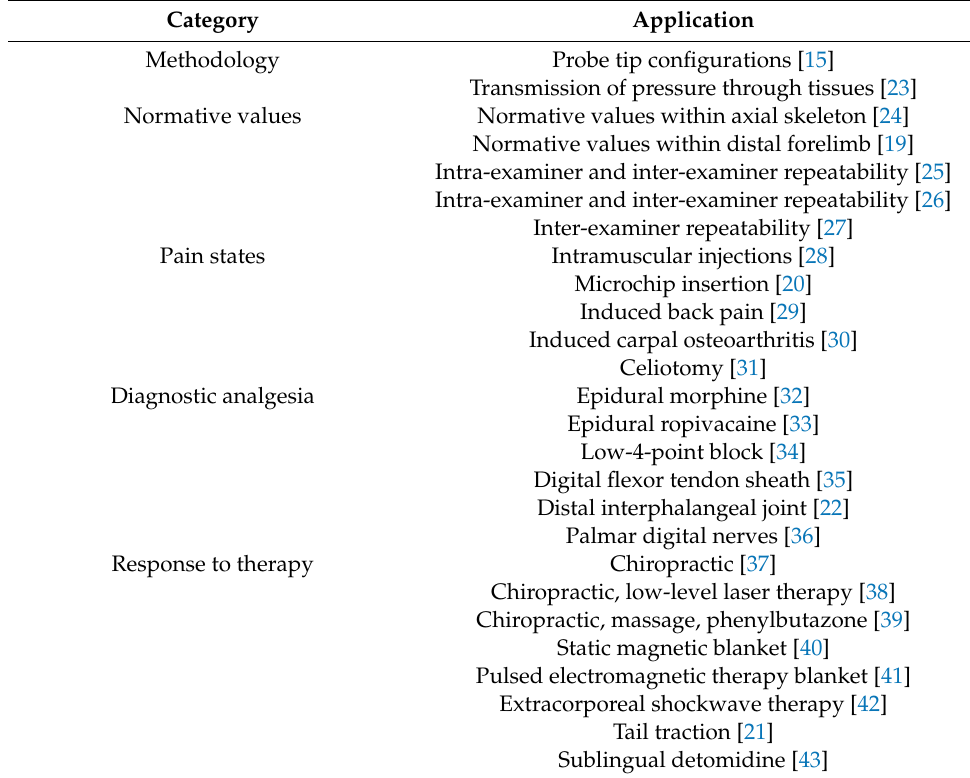
Table 2. Studies that used pressure algometry to assess mechanical nociceptive thresholds (MNTs) in